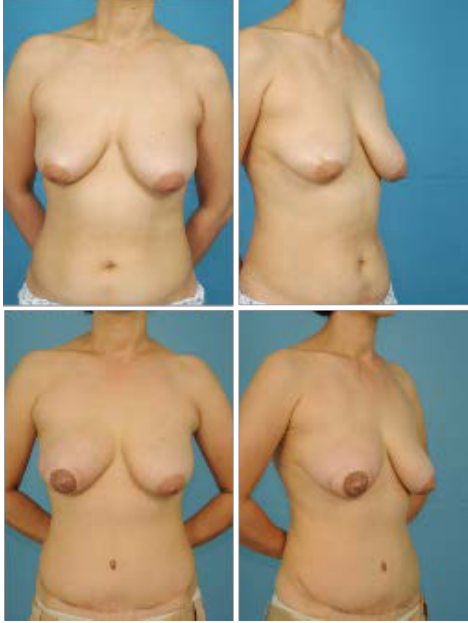
Figure 9. A 39-year-old patient who underwent immediate reconstruction of the left breast with partial muscle resection and innervated muscle sparing and breast reduction of the right breast. ( Top ) Preoperative frontal and three-quarters oblique view. ( Bottom ) Frontal and three-quarters oblique view 11 months post-operative. Fat necrosis in zone 2 was excised under local anesthesia. In the aesthetic evaluation of the IMF, continuity, definition, and symmetry were given scores of 3.7, 4, and 4, respectively.